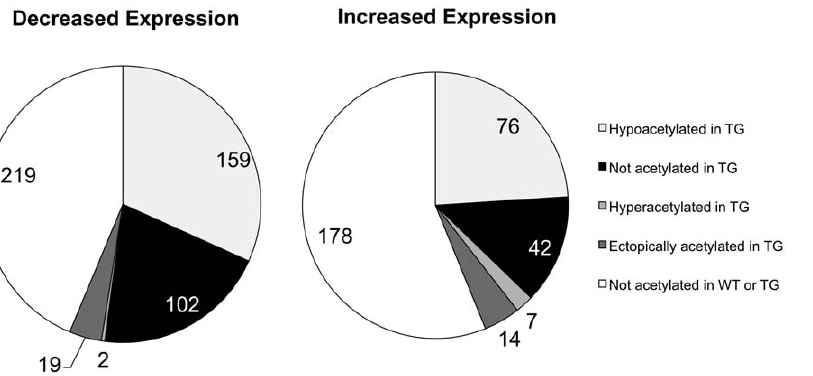
Figure 8. Gene expression changes are not strongly associated with changes in histone H3 acetylation in the R6/2 TG striatum. (A) Classification of differentially acetylated histone H3 genes whose expression are decreased in the TG striatum. (B) Classification of differentially